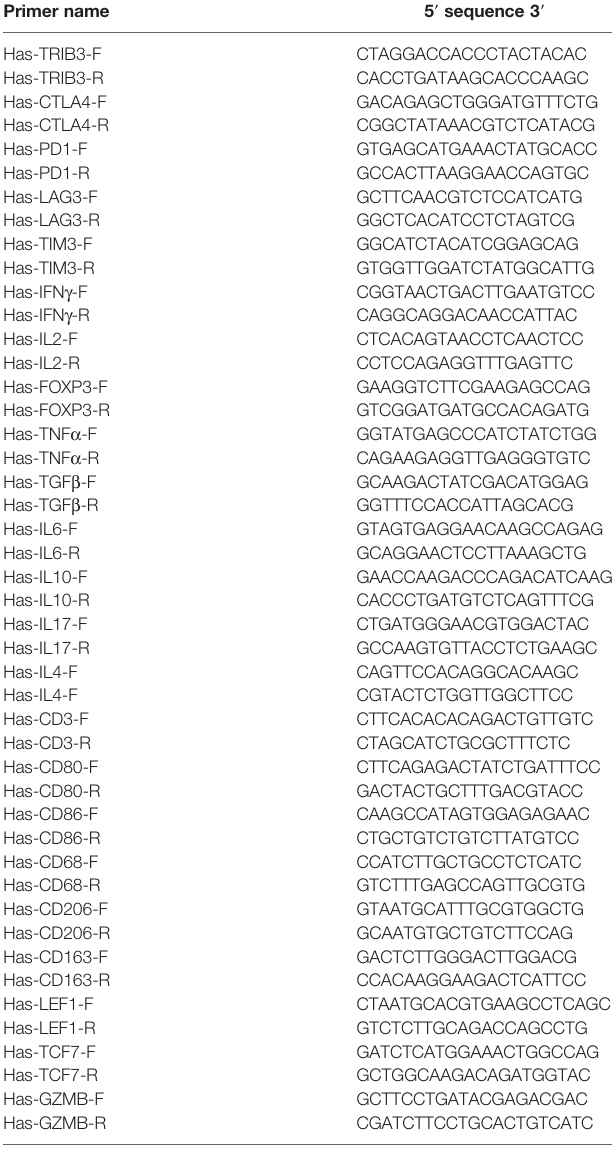
TABLE 1 | The sequences of 23 marker genes regarding tumor